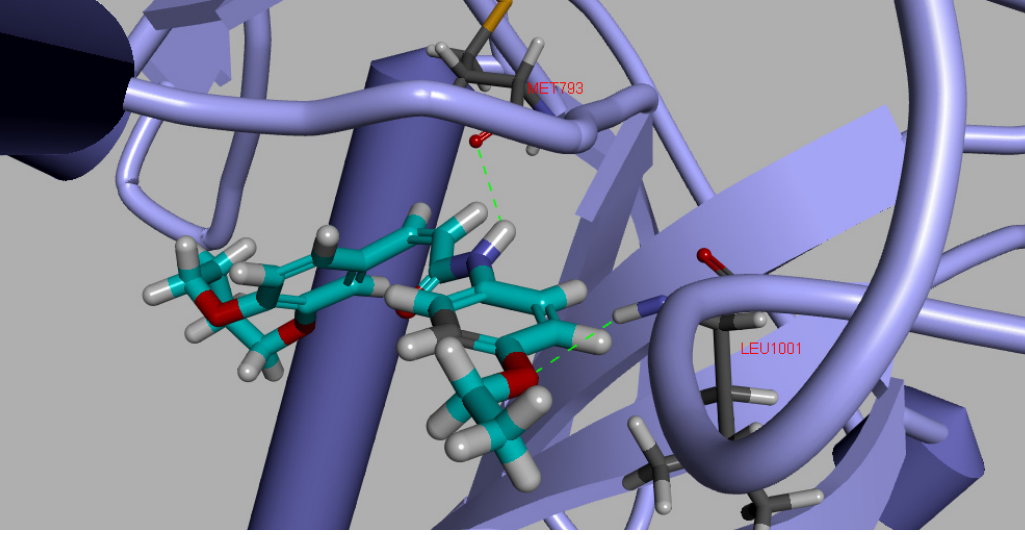
Figure 6. 3D model of the interaction between compound D